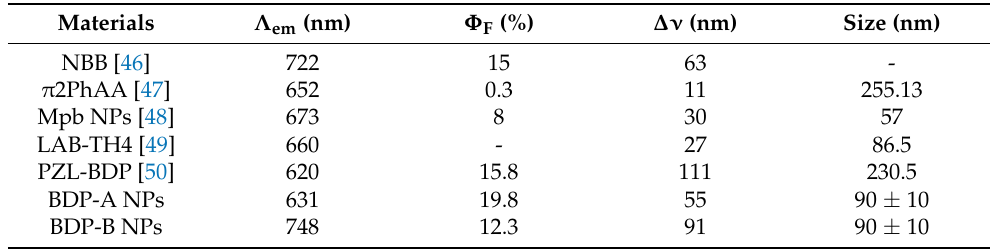
Figure 2. ( a ) Diagram illustrating the preparation method of BDP-A/B NPs. ( b ) TEM image of self-assembly of BDP-A in water. ( c ) Dispersion behavior of BDP-A NPs over time. ( d ) Fluorescence spectra of BDP-A NPs and ( e ) BDP-B NPs. Table 2. The photophysical properties of BODIPY NPs reported in the literature and a comparison with that produced in this work.